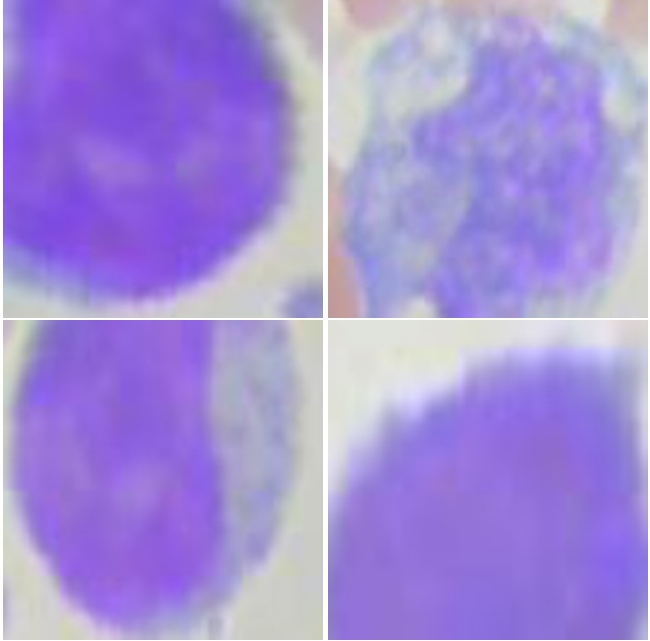
Figure 4. Mononuclear cells classified by the proposed multi-level convolutional neural network. ( upper-left ) Lymphocytes correctly classified; ( upper-right ) monocytes Correctly classified; ( lower- left ) lymphocytes incorrectly classified as monocytes; ( lower-right ) monocytes incorrectly classified as lymphocytes.